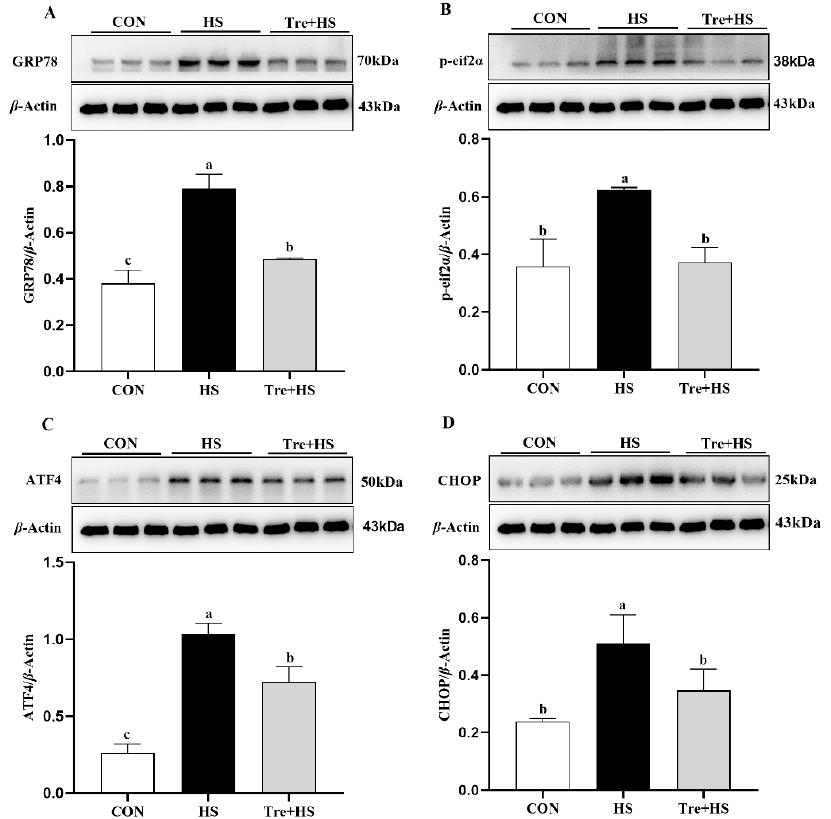
Figure 3. Effects of trehalose on endoplasmic reticulum stress (ERS) response in heat-stressed IPEC-J2 cells. IPEC-J2 cells were cultured at 37 ◦ C until the end of the experiment (control, CON); exposed to heat stress for 2 h (43 ◦ C, HS); or pretreated with 10 mM trehalose at 37 ◦ C for 4 h prior to heat stress exposure for 2 h (Tre + HS). Western blotting analysis of the expression of UPR proteins GRP78 ( A ), p-eif2 α ( B ), ATF4 ( C ), and CHOP ( D ). GRP78: glucose-regulated protein 78; p-eif2 α : phosphorylated eukaryotic translation initiation factor 2 α ; ATF4: transcription factor 4; CHOP: C/EBP homologous protein; Data are shown as mean ± SD (n = 3). Means for variables that do not share a common letter differ significantly ( p < 0.05).